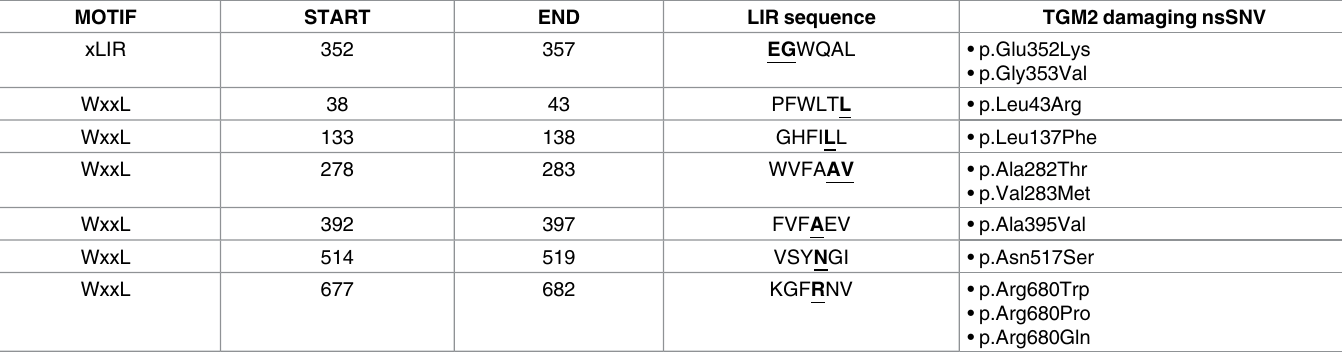
Table 3. Damaging nsSNVs located in potential LC3 interacting regions.